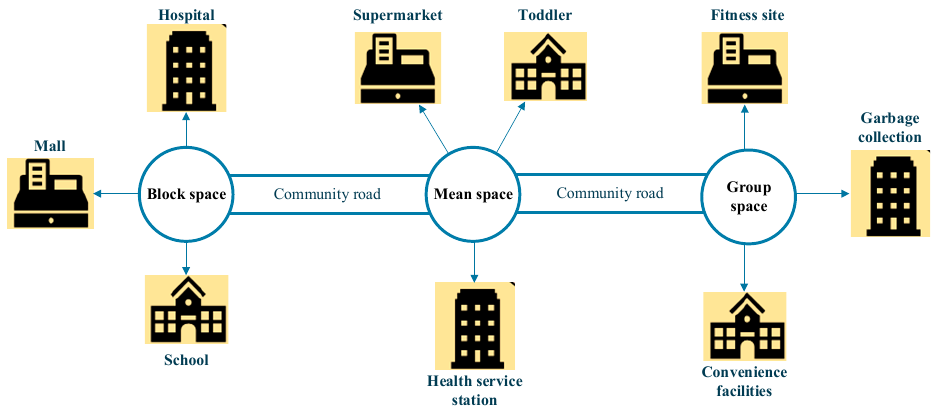
Figure 5. Community three-level prevention and control system.